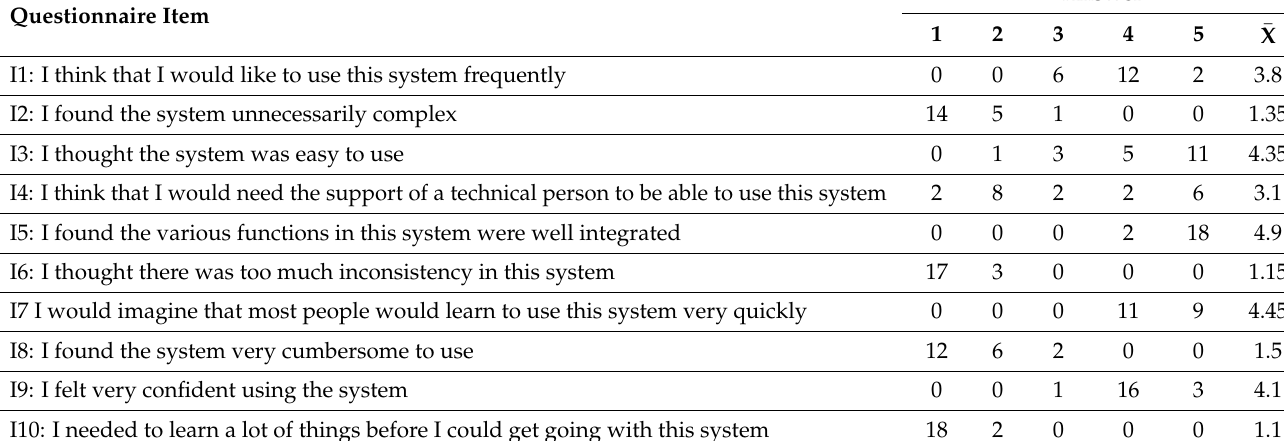
Table 8. SUS test participant